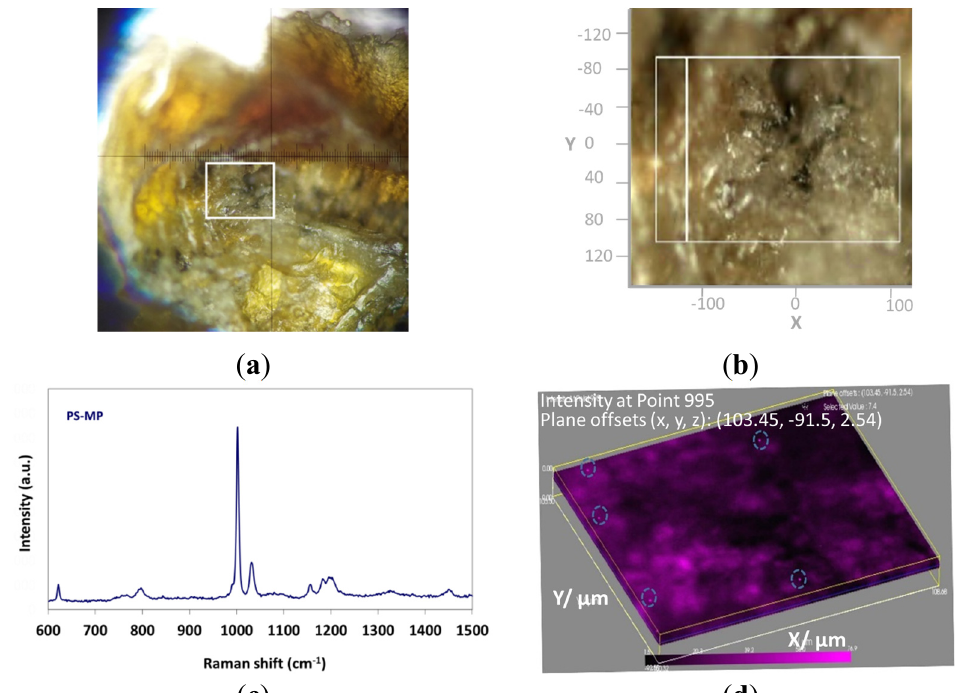
Figure 2. ( a ) Zebrafish gill as observed from the microscope lens, indicating the measured area with the white rectangle, ( b ) The measured area of Figure 2(a) in the x,y,z axes, ( c ) Raman spectrum of PS-MS, ( d ) Still image of the HR volume video map indicating the PS-MS in depth 2.54 μ m of the gill area (the HR volume video map can be found in the Supplementary material).